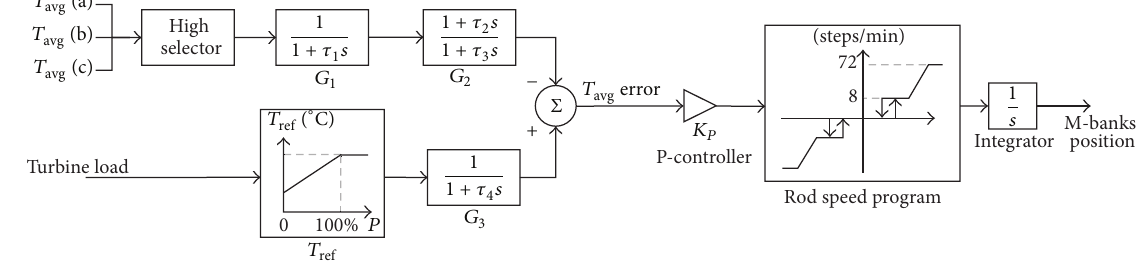
Figure 8: Modified power control system of MSHIM in AP1000.